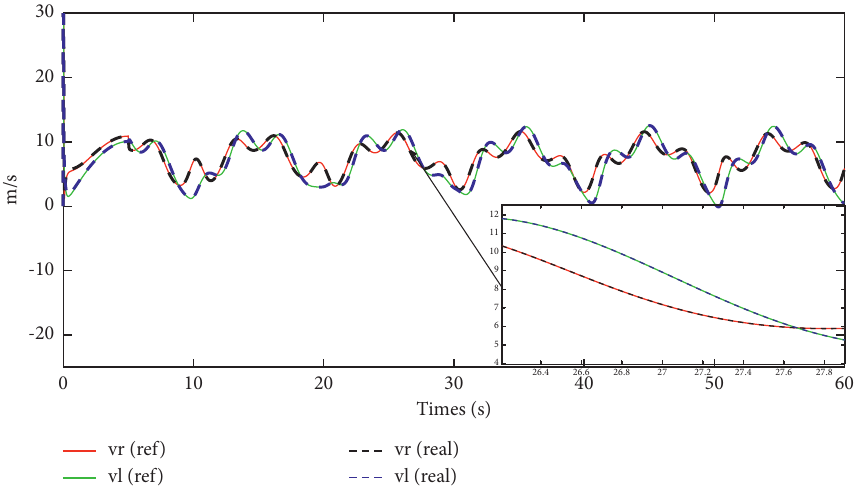
Figure 7: The real velocity of adaptive interval fuzzy type-II for trifolium